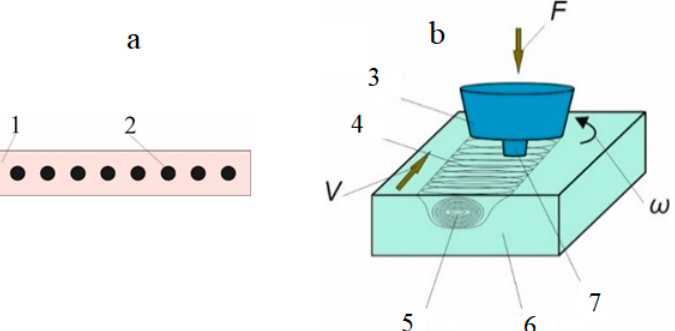
Figure 1. The AA5056 plate with drilled holes containing zirconium tungstate powder ZrW 2 O 8 ( a ): 1—plate made of AA 5056 alloy; 2—holes loaded with the ZrW 2 O 8 powder. The diagram of friction stir processing ( b ): 3—tool support shoulder; 4, 5—SZ; 6—base metal; 7—FSP tool’s pin; F is the